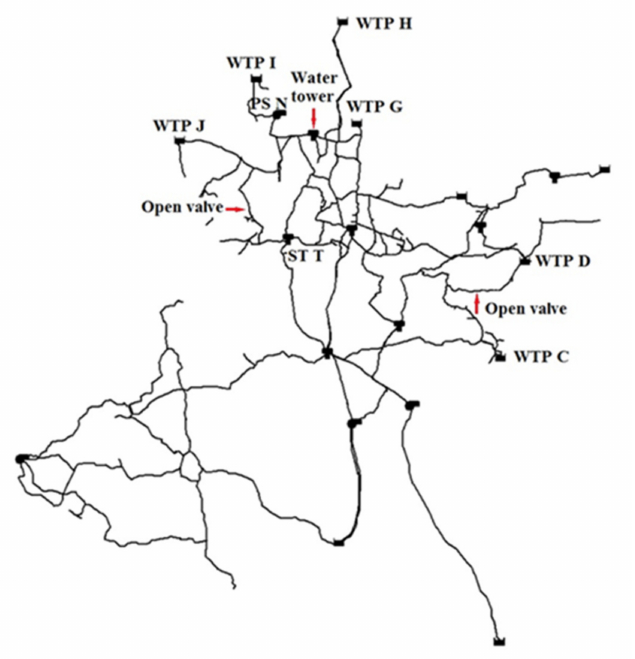
Figure 7. WSS scheme with marked changes for first modification (Scenario no.